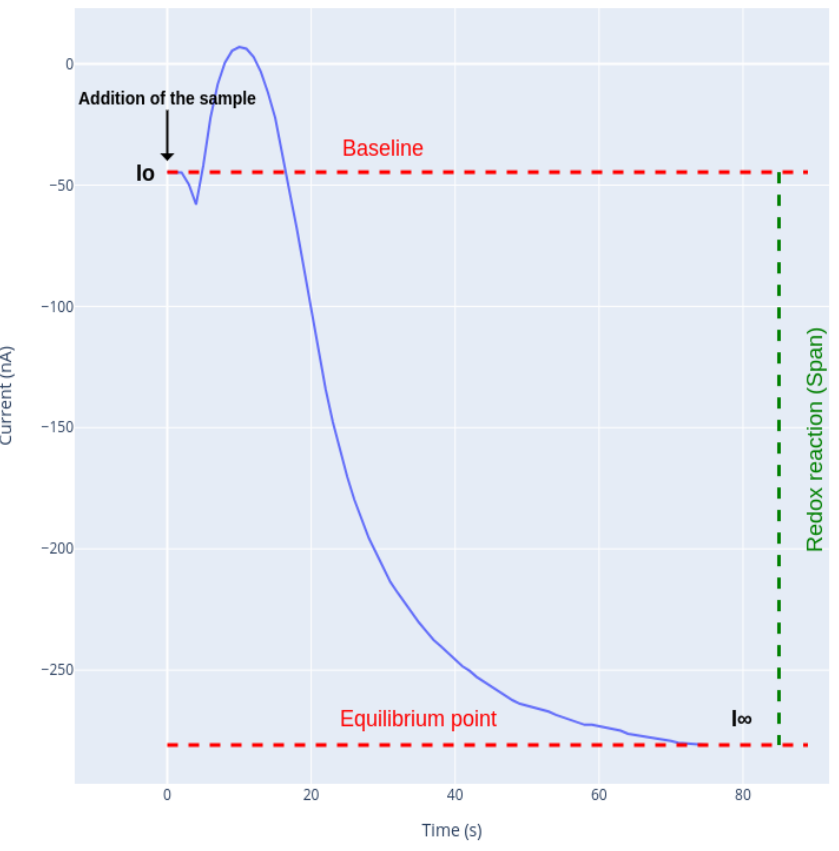
Figure 3. Temporal response of the